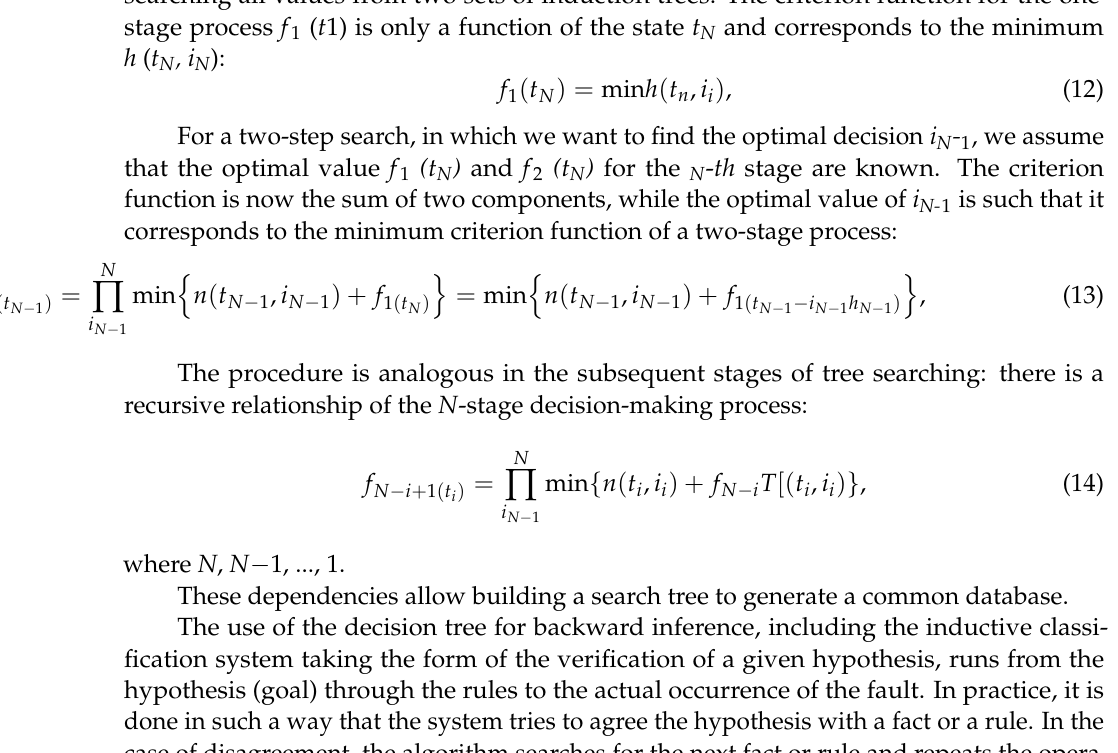
Figure 12. Inductive decision trees for t2 , where C—efficient engine, NI—injection inefficient, and UC—pressure